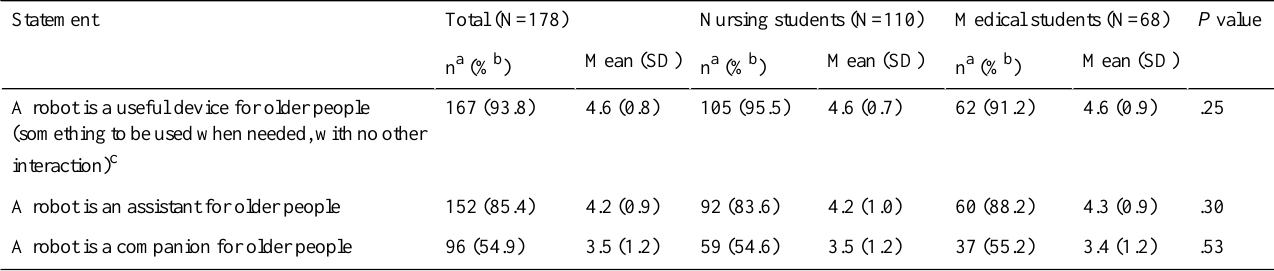
Table 1. Opinions of nursing and medical students about the general role of a robot in the care of older people.